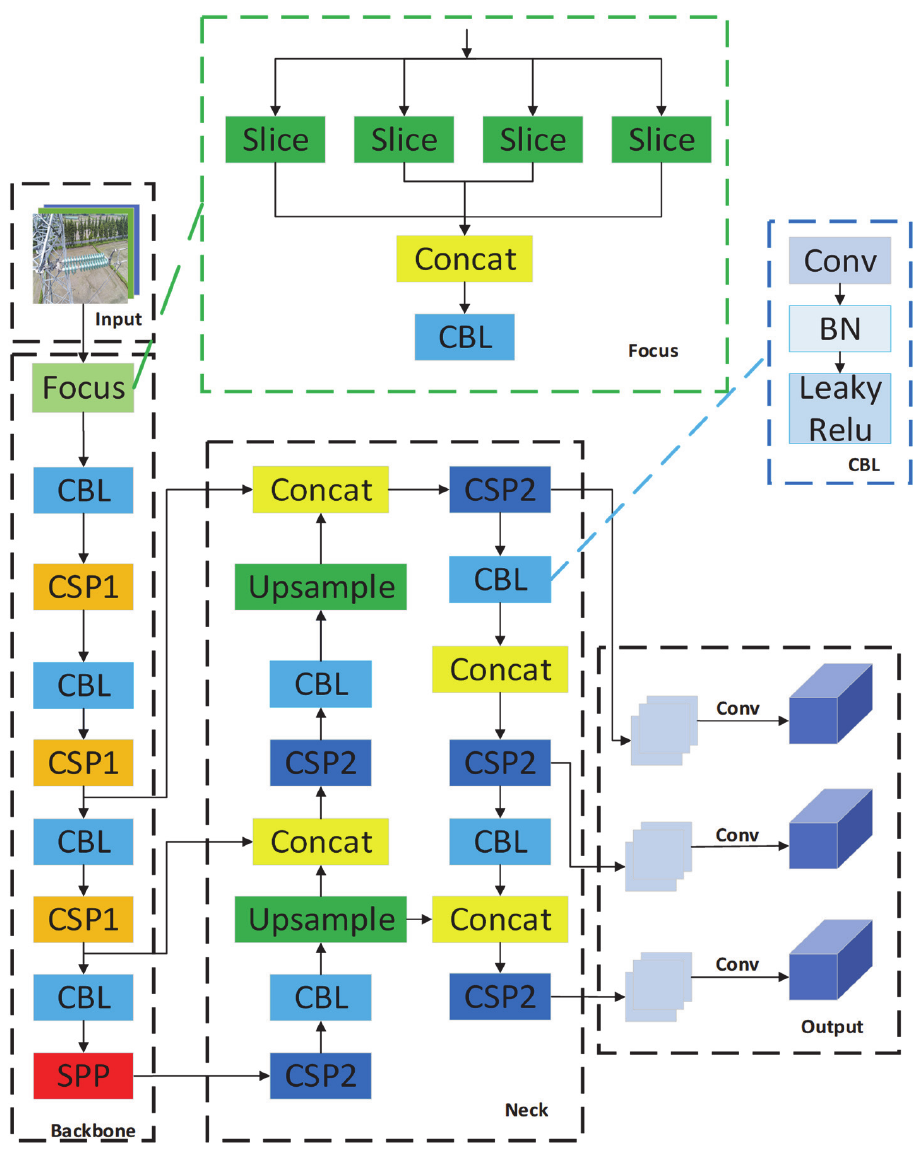
Figure 1. YOLOv5 network model structure diagram.